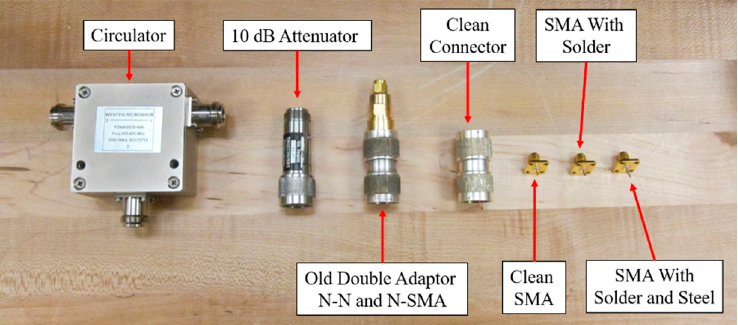
Figure 12. Devices tested for second harmonic characterization.